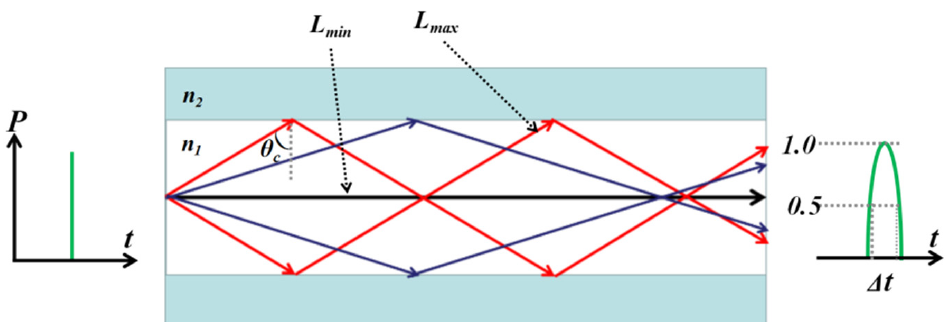
Figure 5. The inter-modal dispersion of the multi-mode gradient-index fiber.